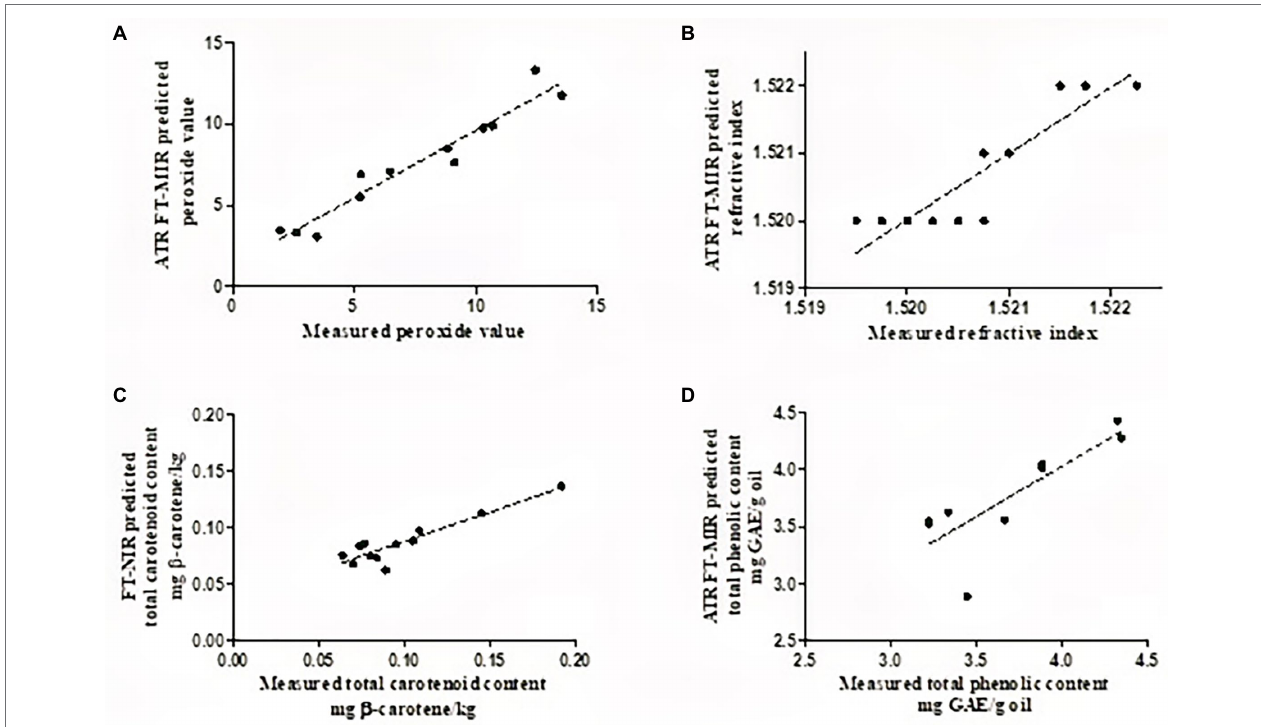
FIGURE 4 | Scatter plots of FT-NIR/FT-MIR predicted (A) , refractive index (B) , total carotenoid content (C) , and total phenolic content (D) , plotted against destructively acquired reference data (sample number =